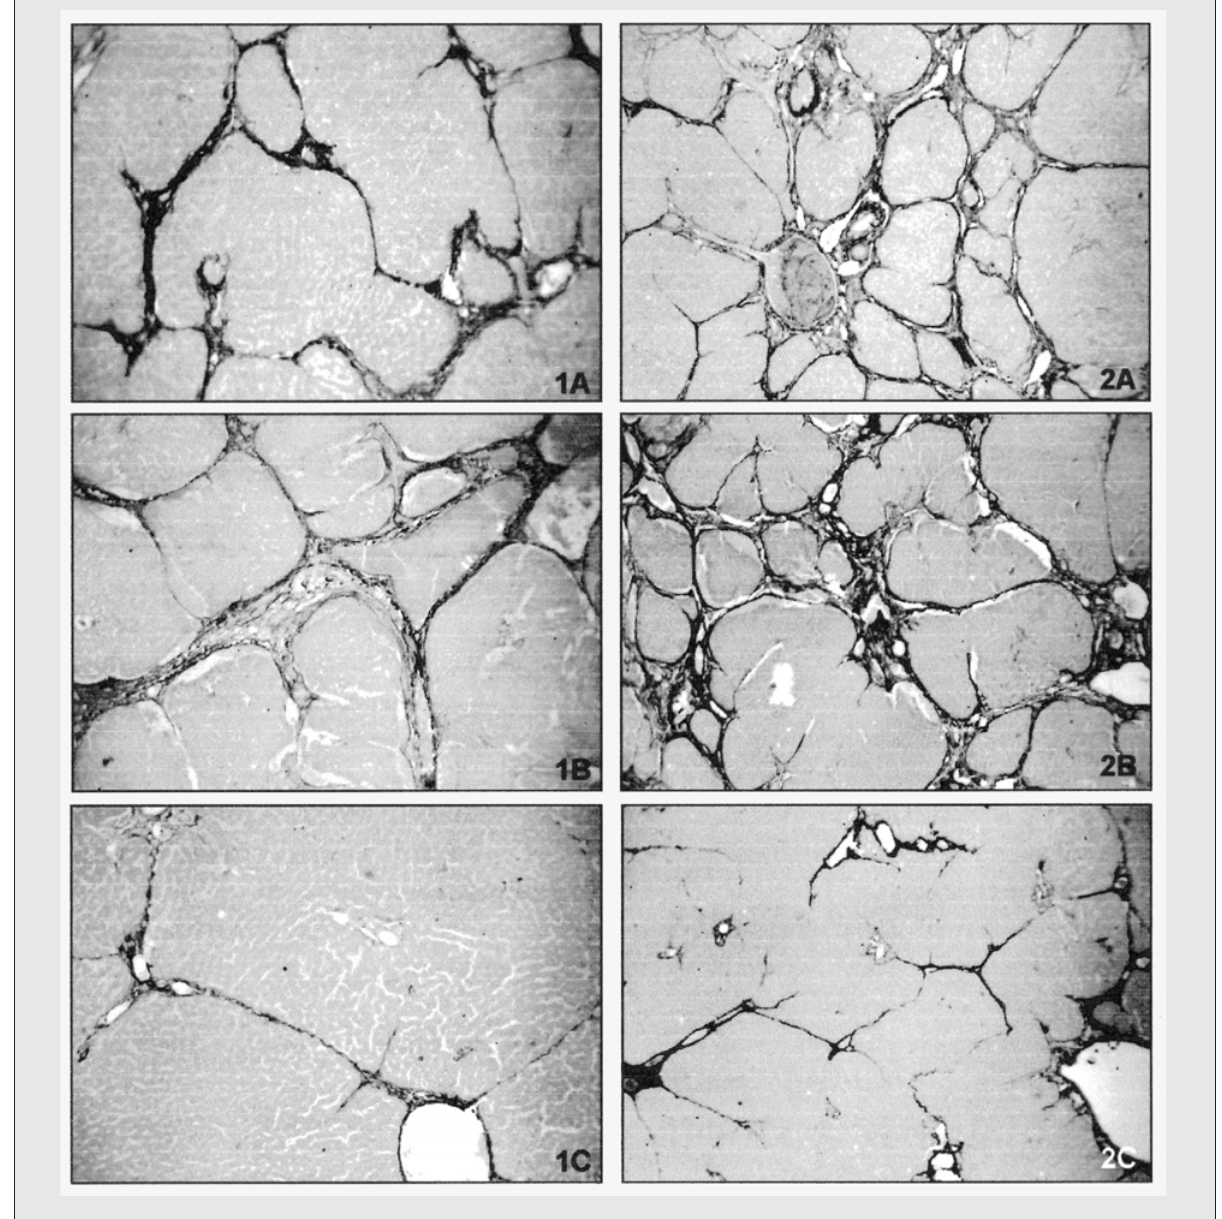
Figure 1 – The picture is representative of the main changes observed in successive specimens taken from the livers of two rats treated with carbon tetrachloride, either for 8 weeks (1A, 1B and 1C) and 12 weeks (2A, 2B and 2C), as seen at different periods of time after drug removal: (1A and 2A: 72 hours; 1B and 2B: 2 weeks; 1C and 2C: 12 weeks). In both instances there is a picture of cirrhosis evolving toward mild septal fibrosis at the end of 12 weeks following CCl4 withdrawal. Sirius-red staining, x